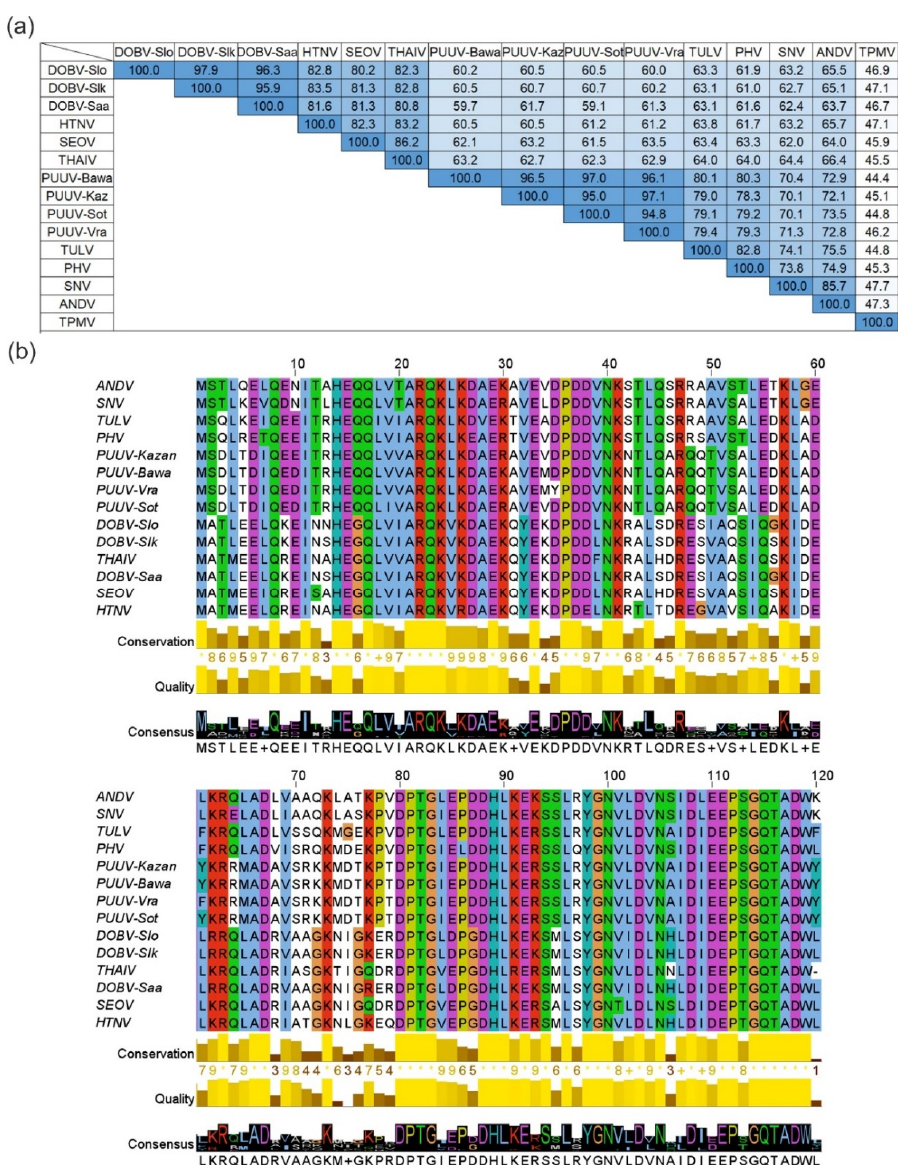
Figure 1. Pairwise identity values and multiple N protein aa sequence alignment of hantaviruses. ( a ) Pairwise identity values (%) of hantavirus N protein aa sequences. Color intensity indicates the aa identity level between N protein sequences. ( b ) Multiple sequence alignment of hantavirus N proteins. Each residue in the alignment is assigned to a color scheme used for alignments in ClustalX if the aa profile of the alignment at that position meets criteria specific for the residue type (blue color—hydrophobic residues, red—positive charge, magenta—negative charge, green—polar, or- ange—glycines, yellow—prolines, cyan—aromatic, white—unconserved if none of the criteria are met). The bar diagrams and the numbers under the alignment indicate sequence conservation level, alignment quality and the consensus sequence. Dobrava-Belgrade orthohantavirus genotype Dobrava, strain Slovenia (DOBV-Slo), genotype Kurkino, strain Slovakia (DOBV-Slk) and genotype Saaremaa (DOBV-Saa); Hantaan orthohantavirus (HTNV); Seoul orthohantavirus (SEOV); Thailand orthohantavirus (THAIV); Puumala orthohantavirus strains Bavaria (PUUV-Bawa), Kazan (PUUV-Kaz), Sotkamo (PUUV-Sot), Vranica/Hällnäs (PUUV-Vra); Tula orthohantavirus (TULV); Prospect Hill orthohantavirus (PHV); Sin Nombre orthohantavirus (SNV); Andes orthohantavirus (ANDV); Thottapalayam thottimvirus (TPMV). The aa sequence identity levels were evaluated using NCBI protein–protein BLAST [50], multi- ple aa sequence alignment was assembled with Clustal Omega [51] and visualized with JalView software